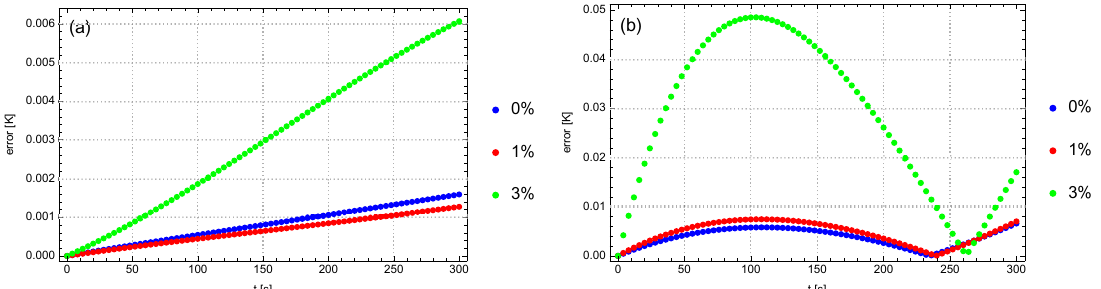
Figure 2. The absolute errors of the solution u reconstruction for the measurement points B ( a ) and C ( b ) in the case of the measurements taken every 4